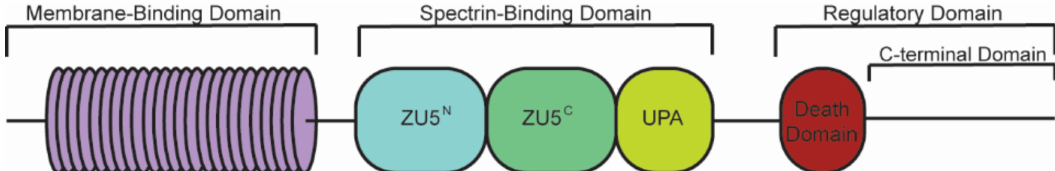
Figure 1. Structure of canonical ankyrin-B. Canonical ankyrin proteins share four domains: a membrane-binding domain (MBD), spectrin-binding domain (SBD), death domain (DD), and C-terminal